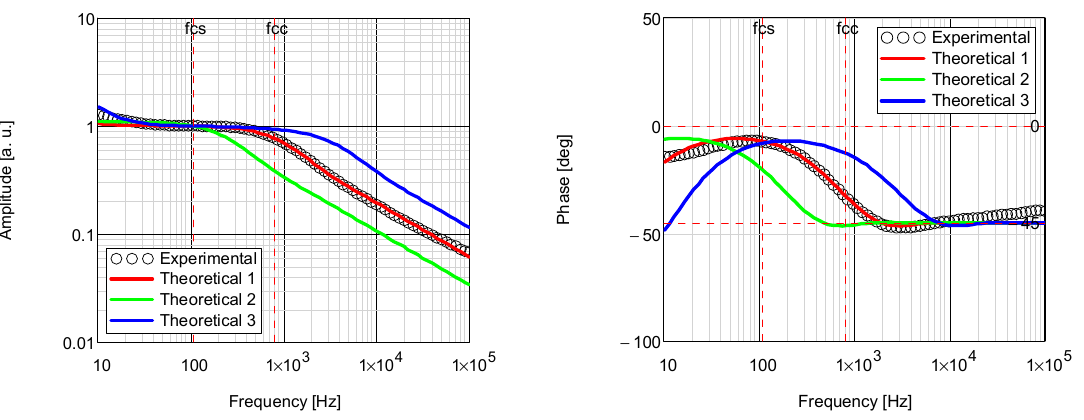
Figure 10. Theoretical and experimental PTR amplitude and phase characteristics obtained for the TMZ-I sample. The solid red line (Theoretical 1) was calculated for the best fit values of thermal pa- rameters ( α c = 2.404 ± 0.073 cm 2 /s, λ c = 2.730 ± 0.168 W/cm ∙ K). The solid green line (Theo- retical 2) was calculated for the best fit values of thermal parameters divided by 4 ( α /4, λ /4). The solid blue line (Theoretical 3) was calculated for the best fit values of thermal parameters multiplied by 4 (4× α , 4× λ ). Circles are experimental data. The PTR experimental and theoretical amplitude and phase frequency characteris- tics of the TMZ-I + Ce(NO 3 ) 3 sample are presented in Figure 11.